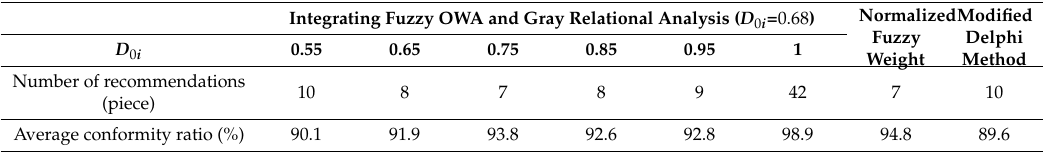
Table 2. Comparison of the first experimental result.